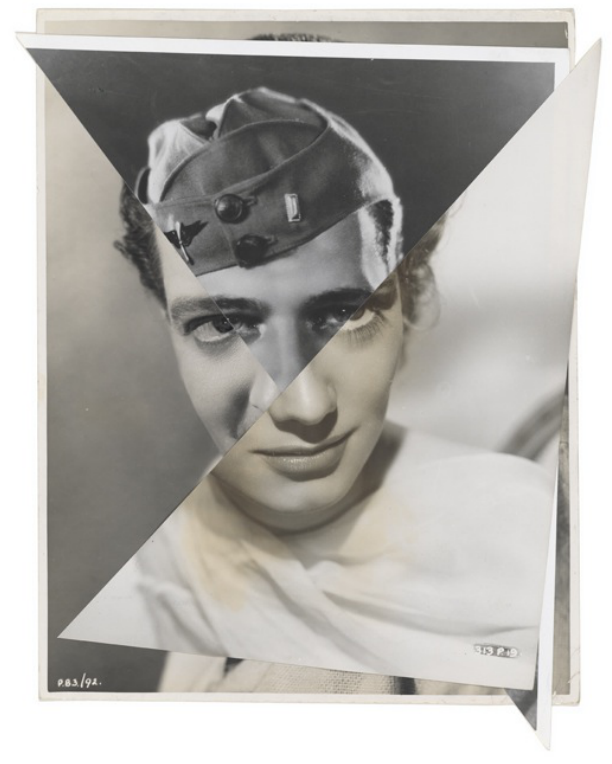
Figure 3: John Stezaker: Untitled (Film Portrait Collage) XXXIV,